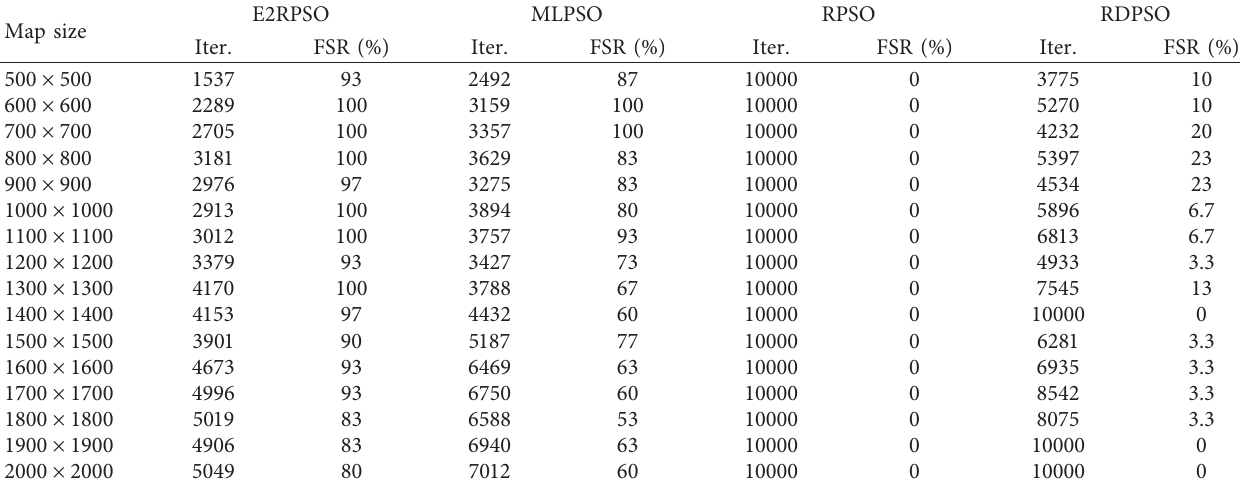
Table 5: Iteration times and full success rate (%) under different map